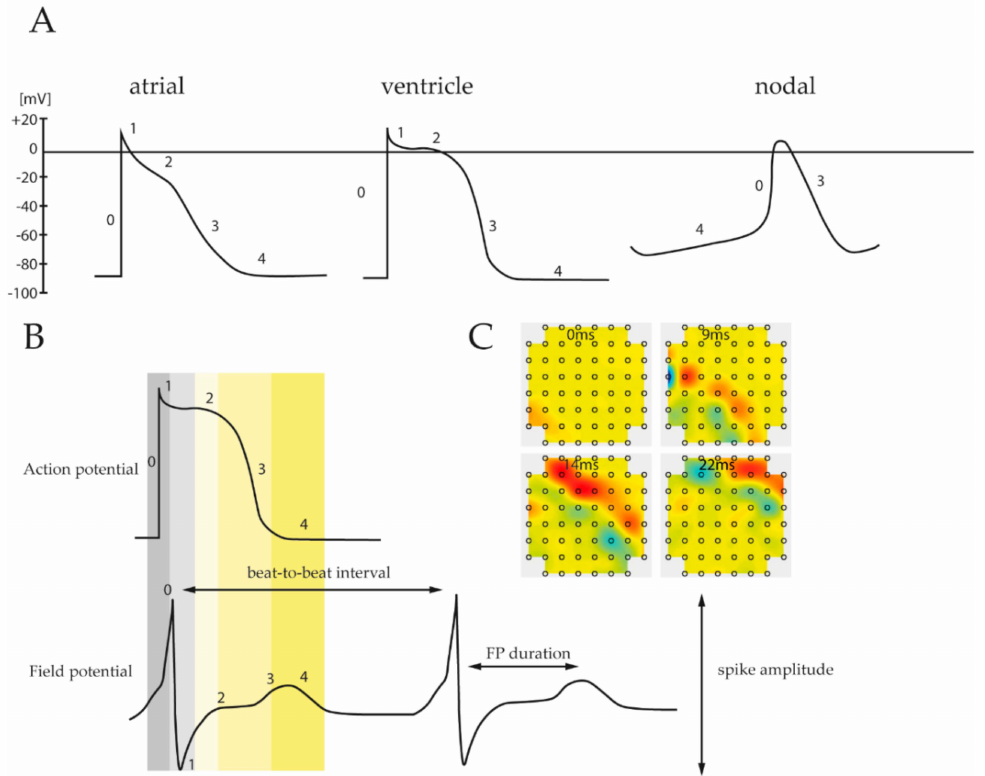
Figure 2. ( A ) Subtype specific pattern of the cardiac action potential. Ventricular, atrial and nodal cells are characterized by unique depolarization and repolarization processes leading to di ff erent action potential (AP) waveforms. Numbers correspond to the di ff erent phases that reflect the activity of involved ion channels. ( B ) Comparison of the di ff erent phases between recorded action potential and field potential. As field potential measurements allow reconstruction of the corresponding action potential it provides important physiological parameters of electrically active cells, including spike amplitude, FP interval, etc. ( C ) Moreover, MEA analysis can be applied to obtain data about prolongation velocity and direction of the field potential spreading throughout the cell